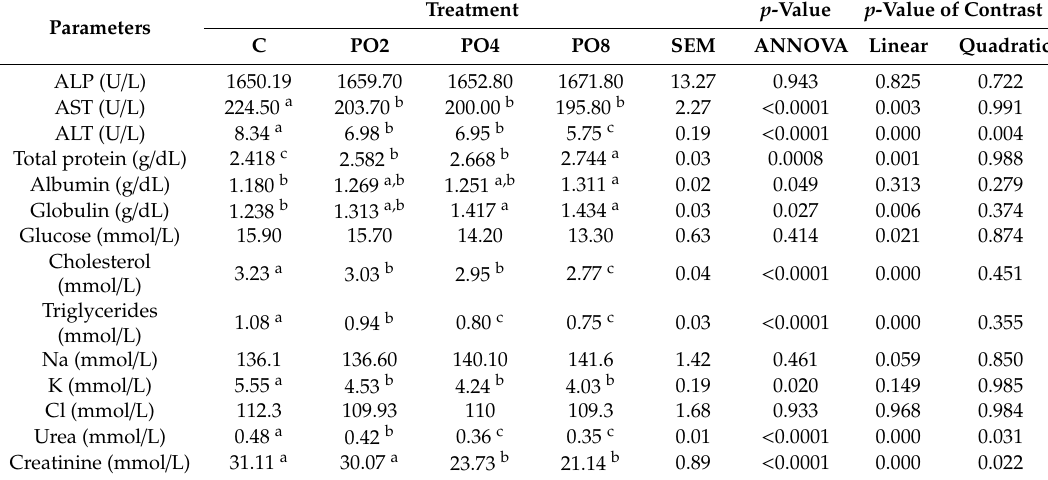
Table 6. Biochemical indicators of chicken blood from birds fed di ff erent supplementation doses of POLM at day 42.